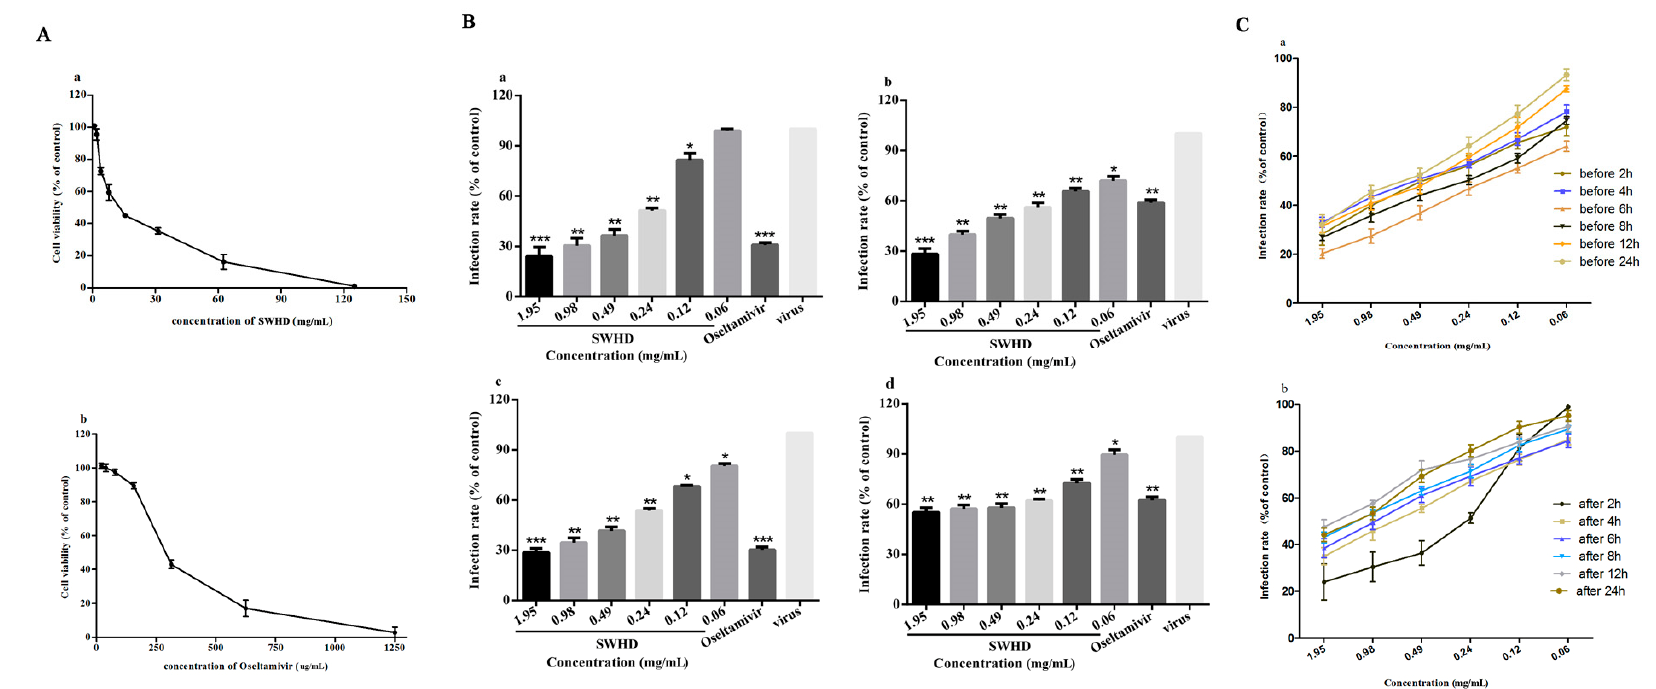
Figure 2. Inhibition the activity of the PR8 virus when given viral inoculation in different stages in vitro. ( A ) The CC50 of the SWHD extract ( a ) and oseltamivir ( b ) for MDCK cells were determined using a CCK-8 assay; ( B ) the inhibitory activity against the virus was determined in vitro by measuring the inhibition of the virus-induced cytopathic effect on cells by crystal violet staining. Antiviral effect assay ( a ); penetration assay ( b ); attachment assay ( c ); internalization assay ( d ); ( C ) the time-dependent inhibitory activity of the SWHD against the virus in vitro: pre-treatment mode ( a ); post-treatment mode ( b ). The values are presented as the means ± S.D. of three individual experiments. * p < 0.05; ** p < 0.01; *** p < 0.001, when compared to the viral control.